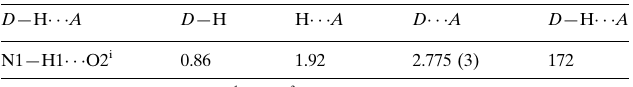
Hydrogen-bond geometry (A˚ , (cid:2)